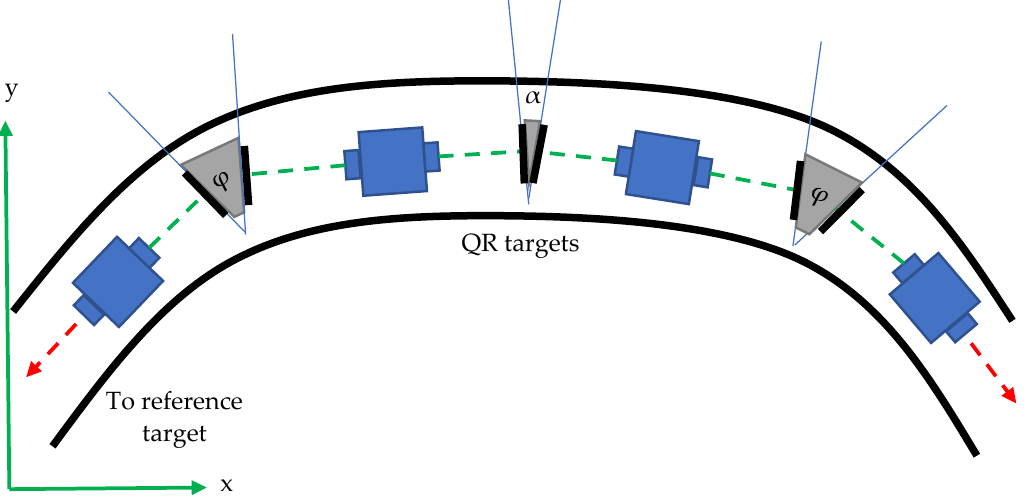
Figure 31. VOS installation scheme for curvilinear structure.